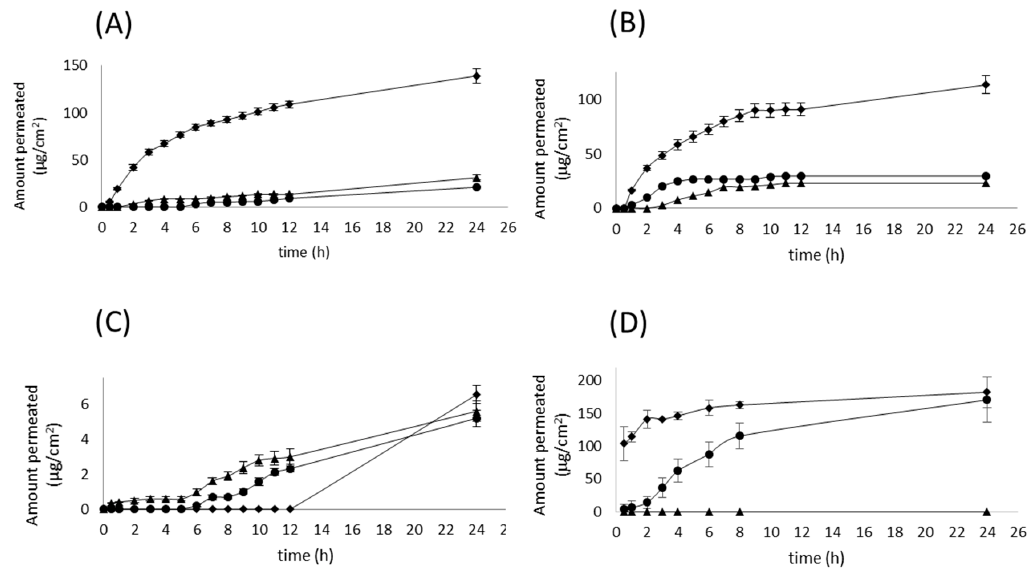
Figure 2. Effect of batyl and chimyl alcohol in Transcutol ® on drug permeation through excised pig